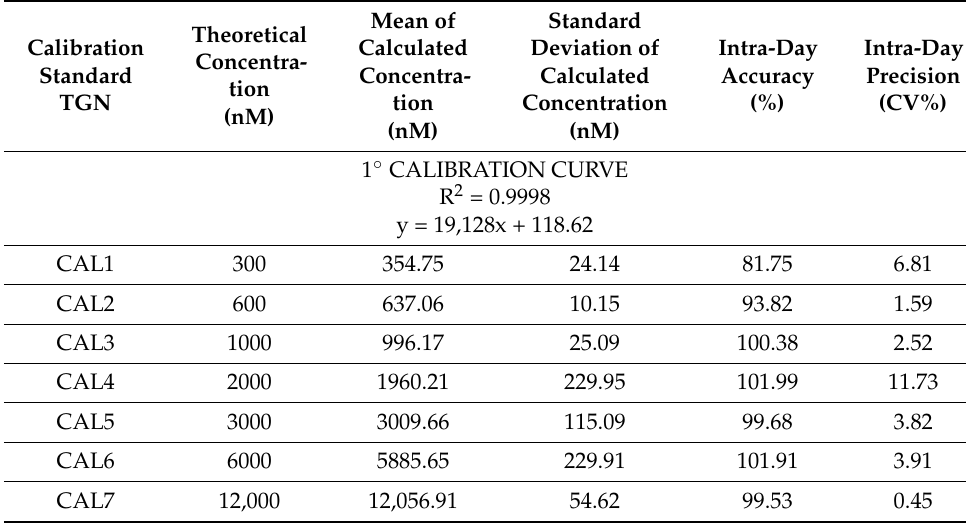
Figure 2. Chromatogram showing the retention times in minutes of the analytes TGN and MMPN (green and blue lines) and of IS (purple line). * indicates the retention times. Table 2. Intra-day accuracy and precision (CV%) referred to CALs of